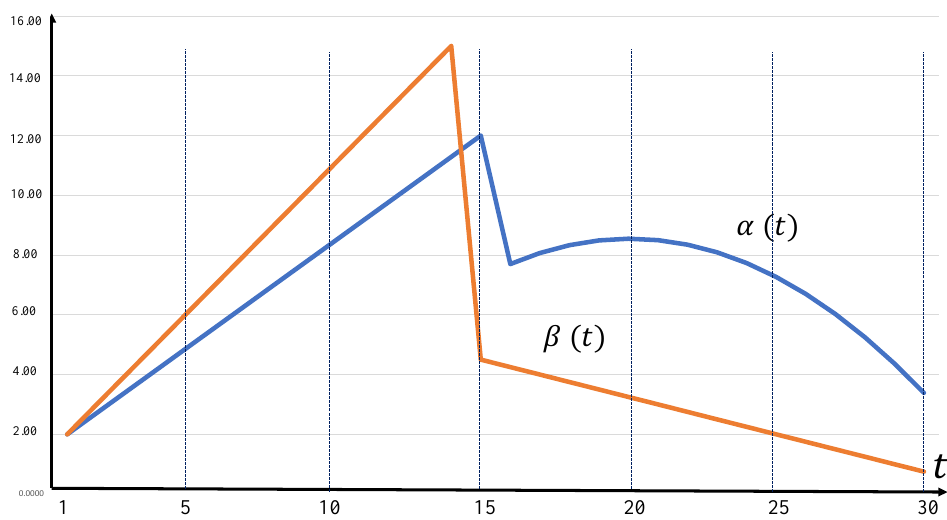
Figure 4. Functions α ( t ) and β ( t ) used in the non-homogeneous birth–death